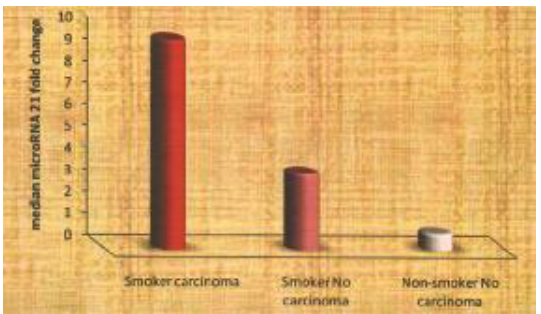
Fig. 1: Median microRNA 21 fold change in the study groups